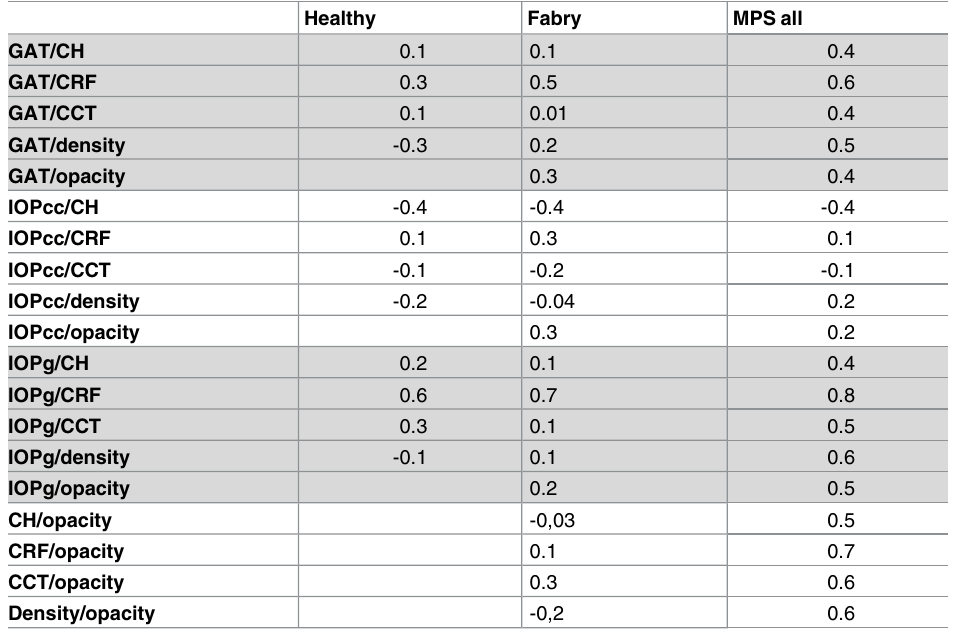
Table 5. The Spearman correlation coefficients evaluated between IOP-measurements: Goldmann applanation tonometry (GAT), corneal compensated intraocular pressure (ccIOP), Goldmann corre- lated intraocular pressure (IOPg) and corneal biomechanical parameters: central corneal thickness (CCT), corneal hysteresis (CH), corneal resistance factor (CRF), corneal density and the grade of cor- neal opacity in all study